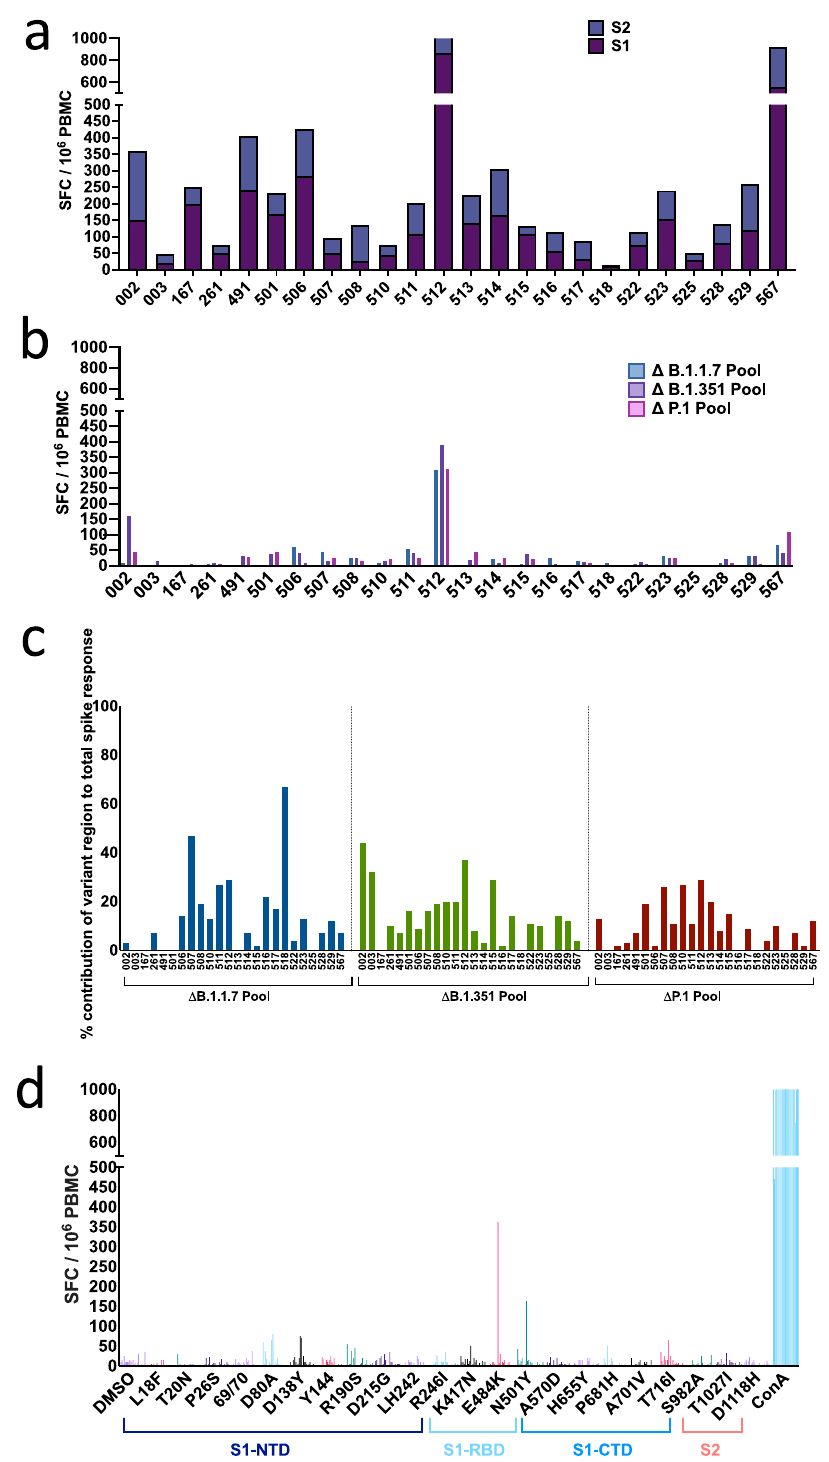
Fig. 4 ELISpot responses to prototype, B.1.1.7, B.1.351 and P.1. T cell responses were measured using IFN- γ ELISpot assays in 24 healthy volunteers, 7 – 17 days after receiving the 2nd dose of BNT162b2. a T cell responses to 15 – 18-mer peptides in B strain overlapping by 10 amino-acids and spanning the entire spike region. b Summed T cell responses to peptides from B strain that mapped to sites with mutations in B.1.1.7 ( n = 17 peptides), B.1.351 ( n = 21 peptides) and P.1 ( n = 22 peptides). c Percentage contribution T cells (using B peptides) that target mutational regions within B.1.1.7, B.1.351 and P.1, relative to the total T cell spike response in each of the 24 volunteers. d T cell responses to 22 individual peptides in B strain that have corresponding mutations in B.1.1.7, B.1.351 and P.1 variants. Standardised ELISpot assays were run in triplicate for background and spike peptides and duplicates for all others to allow cell preservation. DMSO control with matching percent DMSO was also used in all assays to account for DMSO content in peptide pools. Each bar represents one volunteer with a positive response (de fi ned as a response to the peptide minus the background that was greater than twice the background). SFC/10 6 PBMC = spot forming cells per million peripheral blood mononuclear cells, with background subtracted.